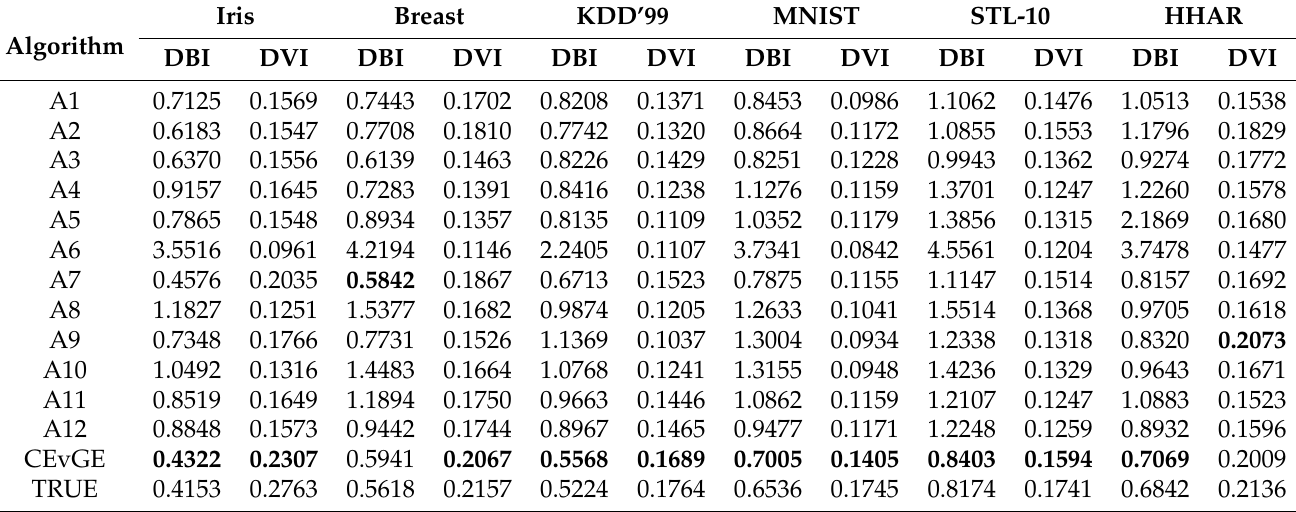
Table 6. Internal indexes of different algorithms on real data